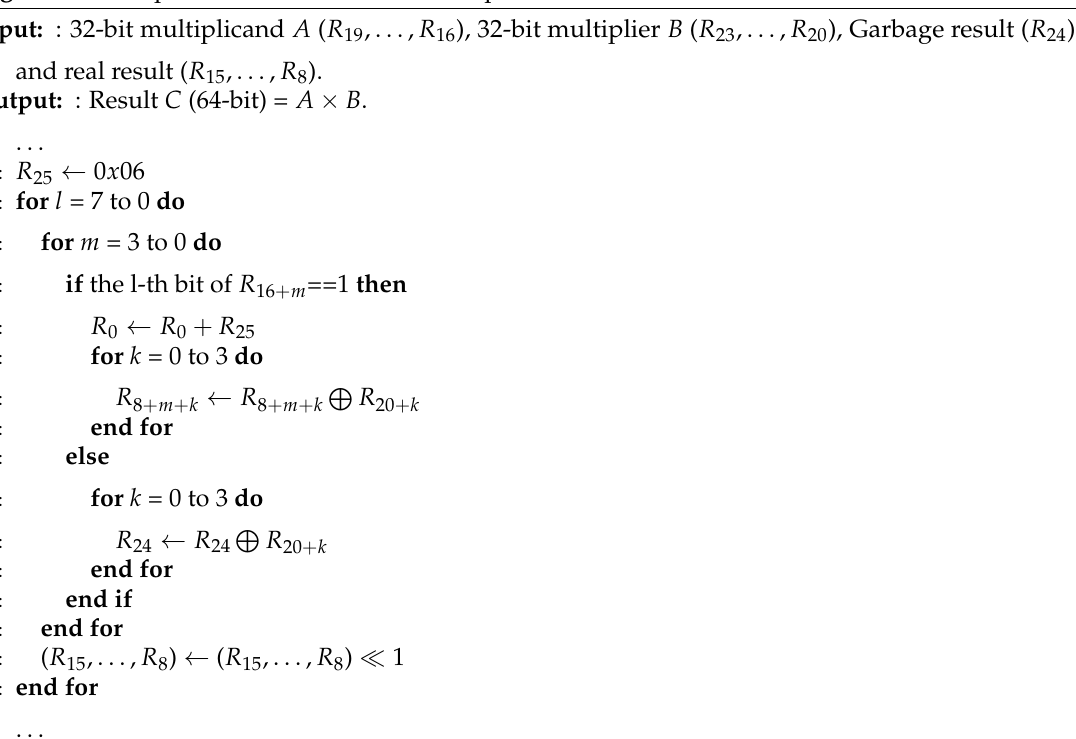
Figure 2. Comparison of 32-bit multiplication in terms of power trace, ( Top ) Seo and Kim [10], ( Bottom ) this work, Figure is generated by us in this paper. Algorithm 1 Proposed method for 32-bit